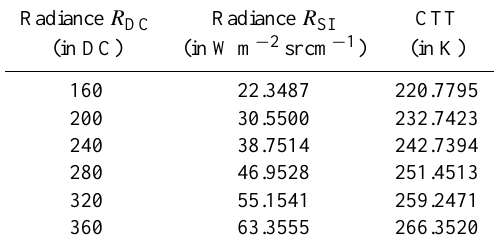
Table 1. Conversion table (channel 09 of SEVIRI) of IR radiance in digital counts ( R DC ) to IR radiance in the International System of units ( R SI ), and to CTT (in